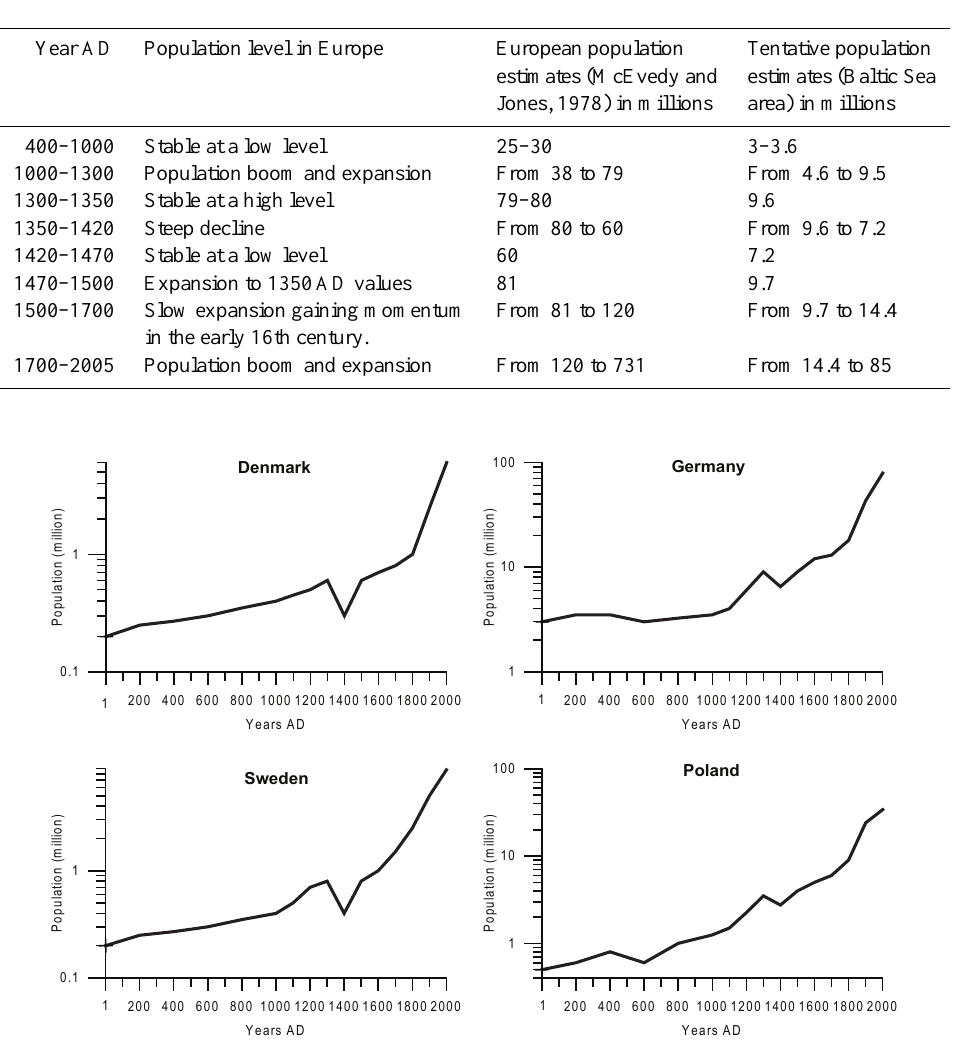
Table 1. Total population data for Europe (McEvedy and Jones, 1978) and the Baltic Sea area. Please note that the population estimates for the Baltic Sea drainage area are based on the assumption that the population in the Baltic region has always been approximately 12% of the total European population (i.e. as during the modern time period).